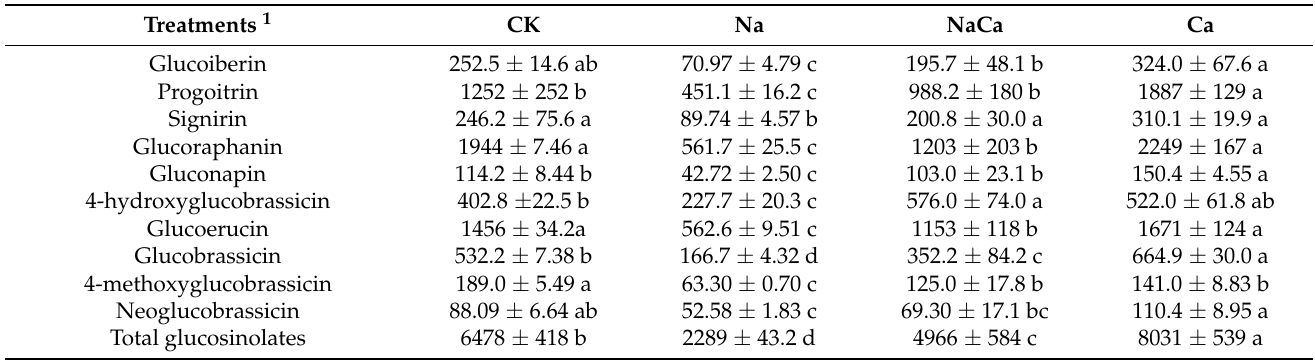
Table 1. Glucosinolates composition and content ( µ mol/100 g dry weight) in shoots of broccoli microgreens under different treatments.